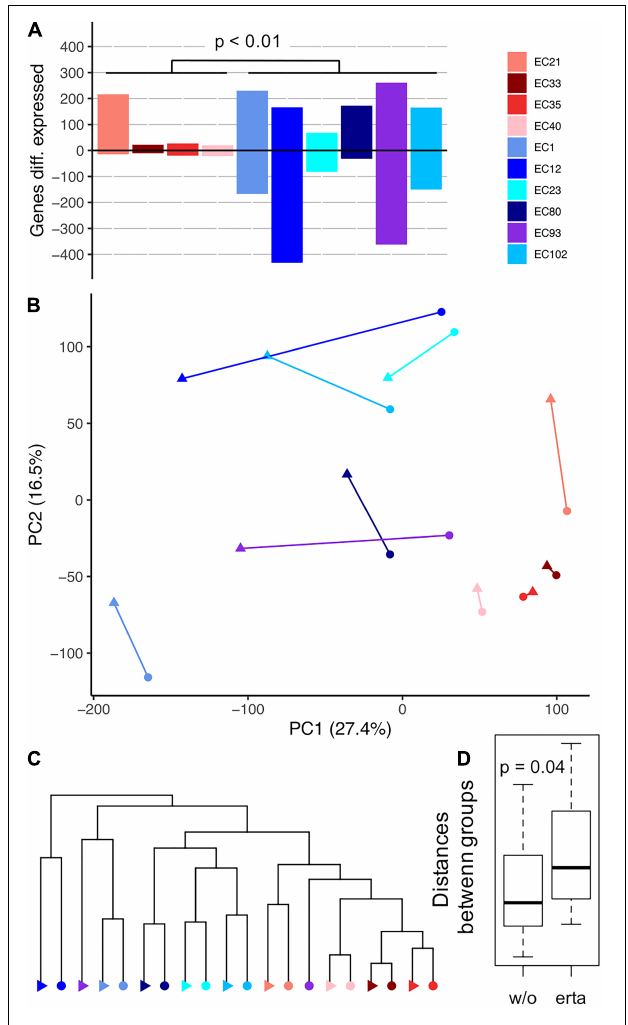
FIGURE 3 | Gene expression results of strains grown in continuous culture in steady-state ( + / − ertapenem) are shown. Panel (A) displays amount of differentially expressed genes of individual strains during growth with the antibiotic compared with growth without ertapenem. All genes that showed a TPM > 10 and a fold change > 1 were considered; the p -value (Student’s t -test) refers to amount of differentially expressed genes between the two groups. A principal component analysis based on expression patterns of shared genes is shown in panel (B) and results of hierarchical clustering are shown in panel (C) (circles and triangles represent results from growth with and without ertapenem, respectively). Euclidean distances of all pair-wise comparisons between strains of individual groups ( − / + ertapenem; w/o/erta) is shown in panel (D) ( p -value was based on Student’s t -test